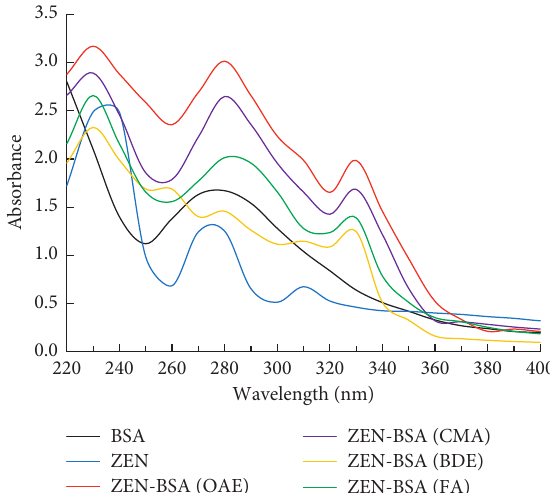
Figure 7: UV spectra of ZEN-BSA synthesized via the four